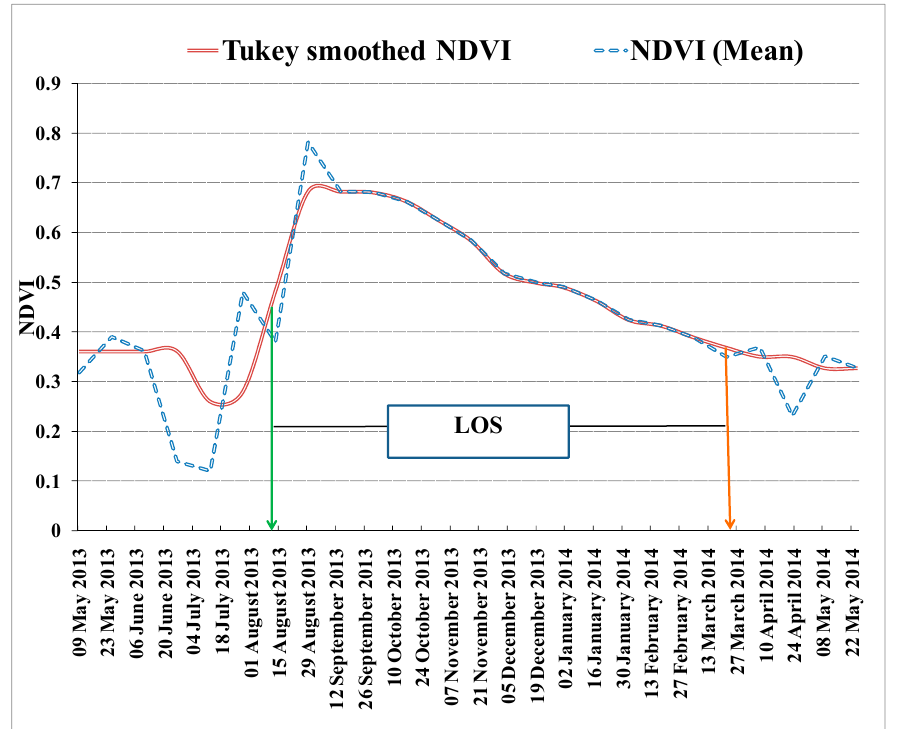
Figure 13. Raw MODIS NDVI and TS-smoothed reconstructed NDVI time series of year 2013–2014 for derivation oflength of the season in Tectona grandis indicated between green and orange arrows.